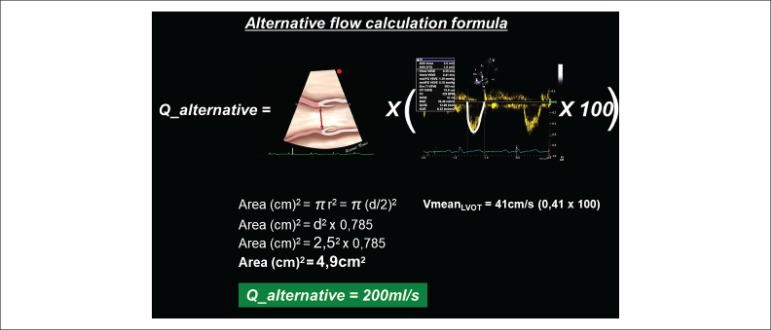
Alternative flow calculation formula where: Qalternative is flow in
mL/s, ASTLVOT is the sectional transverse area of the left
ventricular outflow tract (LVOT) in cm2, and VmeanLVOT is
the mean blood flow velocity by pulsed wave Doppler at the LVOT level during
left ventricular ejection, being expressed in m/s.